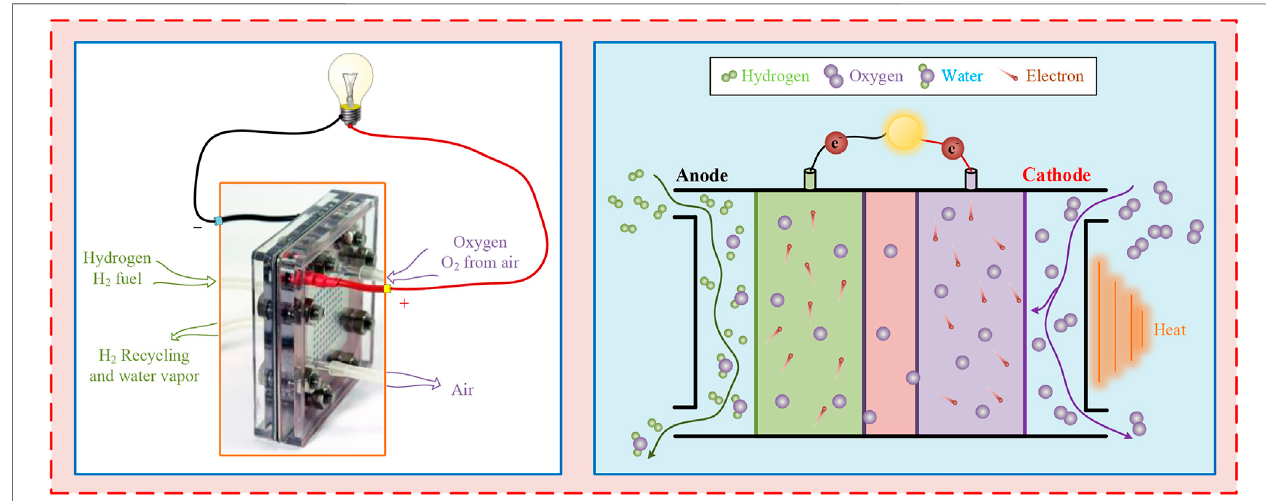
FIGURE 1 | Electrochemical mechanism of the